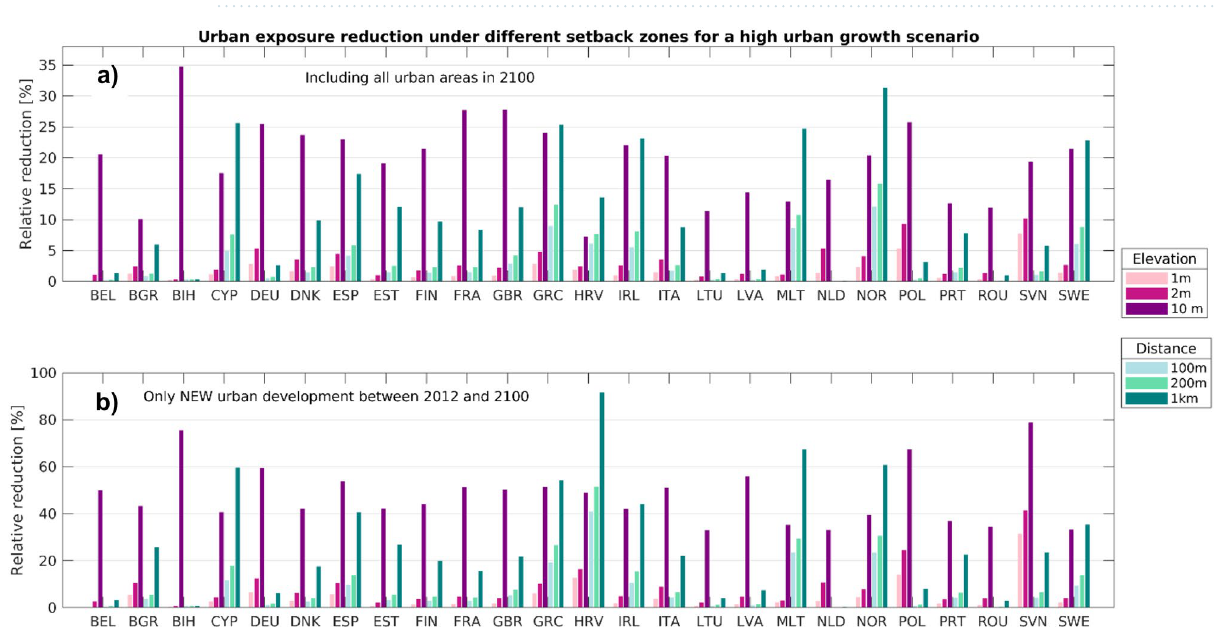
Figure 6. How effective are setback zones in reducing future urban exposure in the E-LECZ. ( a ) Relative reduction in overall urban exposure in the E-LECZ under different setback zones in 2100. ( b ) Relative reduction in urban exposure of new urban development between 2012 and 2100 [high urban growth scenario]. Please note: Y-scale is changing between the